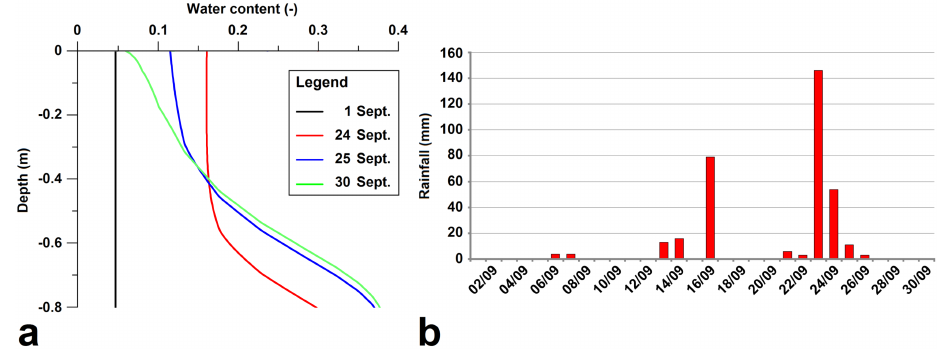
Figure 8. (a) Resulting water content trend vs. depth at four different simulation times (1, 24, 25 and 30 September); (b) September 2009 daily rainfall data recorded at the Fiumedinisi rain gauge station.